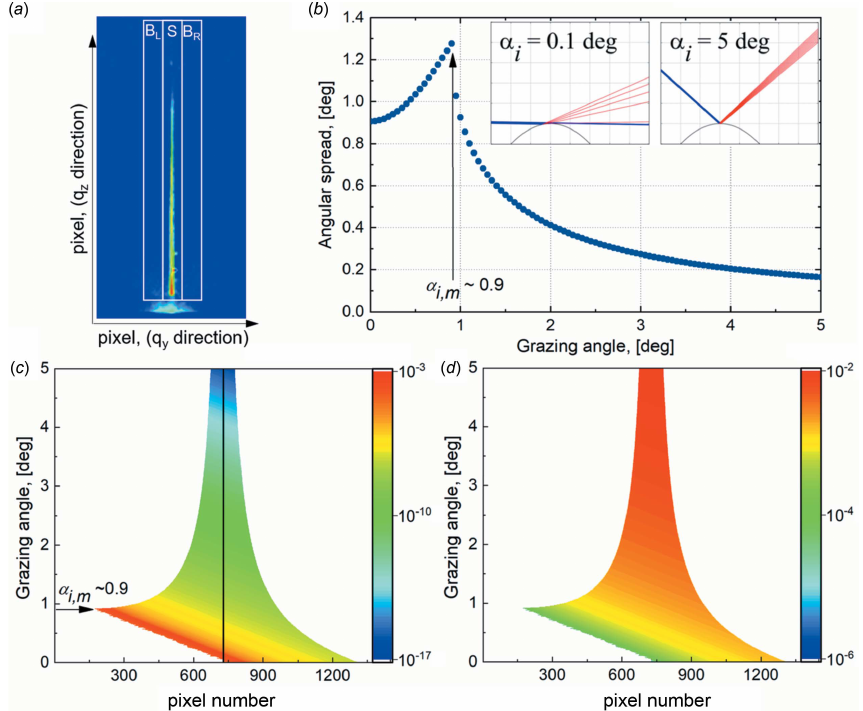
Figure 4 ( a ) Example of a fan of the reflected beam from the curved surface of the molten copper (Sample 3, ID10/ESRF data). Three white rectangles of equal area indicate the areas for calculation of the background (B L , B R ) and the scattered signal (S) for each horizontal cut through the image. A halo below the white rectangles is the parasitic scattering of the primary beam. ( b ) Simulated angular spread value of the beam on a curved surface with a curvature radius of 200 mm and a vertical beam size of 50 m m. Inserts demonstrate the angular spread at effective grazing angles of 0.1 and 5 (cid:6) (from left to right) for the beam represented with nine rays and seen on a detector plane located at 1 m (scale of the vertical grid is 1 mm). In the case of 0.1 (cid:6) , only five rays reflect, and the four others go above the sample, while, in the case of 5 (cid:6) , all nine rays reflect from the sample surface. ( c ) 2D map of simulated X-ray reflectivity on the curved surface for a set of effective grazing angles. The ordinate of the map is the effective grazing angle (cid:5) i , while the abscissa is pixels of the effective 1D detector. The horizontal line at each (cid:5) i represents the reflected beam intensity distribution along the 1D profile in the XOZ plane. Each pixel on the map corresponds to a local grazing angle (cid:5) i, h . Parameters of the calculation: radius of the curved surface of liquid copper at T = 1400 K is 200 mm; incident beam size (2 W V ) is 50 m m; detector pixel size is 55 m m, and sample-to-detector distance is 1.0 m. The vertical line at pixel 728 is a guide to the eye of the effective 1D detector center where (cid:5) i, h = (cid:5) i . The beam’s intensity reaching the detector without reflection is not added to the graph. The color bar corresponds to the logarithm of intensity. ( d ) 2D map of the incident beam contribution fraction to the scattering in a pixel. These values are used for pixel-by-pixel normalization of intensity in Fig. 4( c